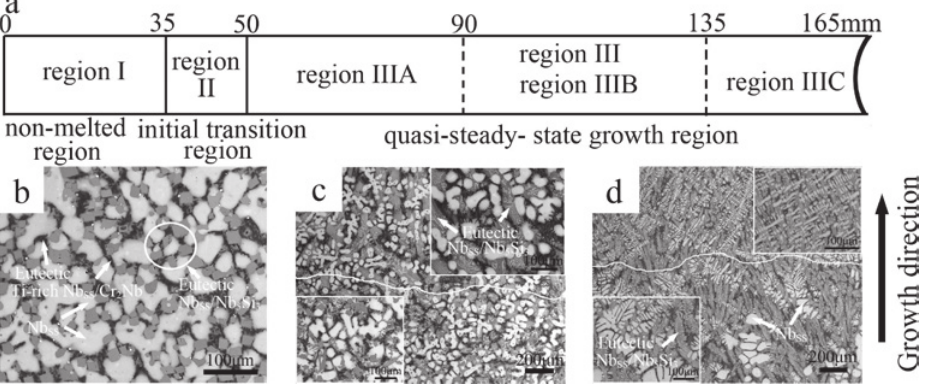
Fig. 1: (a) Schematic diagram of the regions in the DS bar1; (b) the non-melted region; (c) the initial transition region; (d) the upper section of initial transition